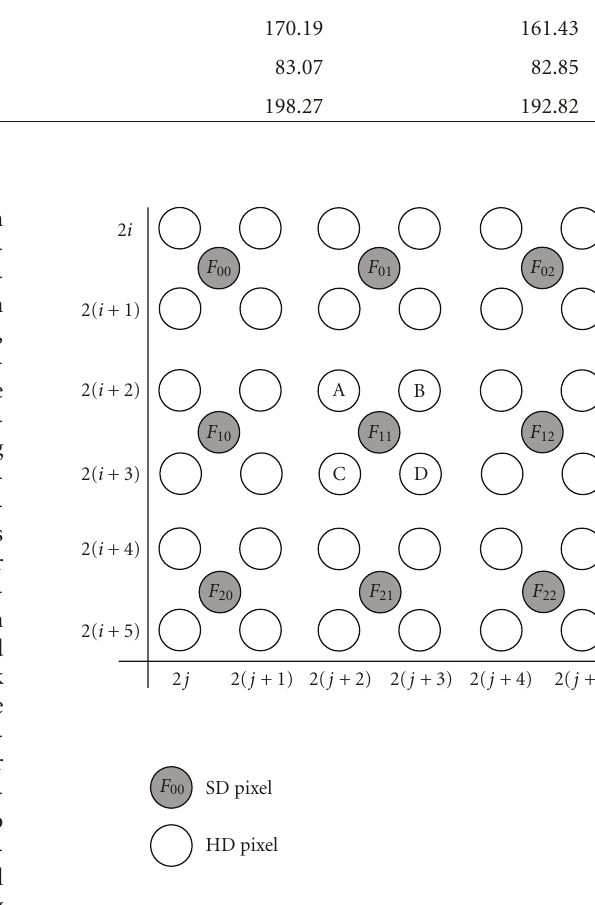
Figure 4: Aperture used in the proposed method. The white pix- els are interpolated HD pixels ( F HD ). The black pixels are SD pixels ( F SD ), with F 12 as a shorthand notation for F SD (1,2) and so forth. The HD pixel A that corresponds to F HD (2( i + 2),2( j + 2)), is inter- polated using nine SD pixels ( F 00 up to F 22